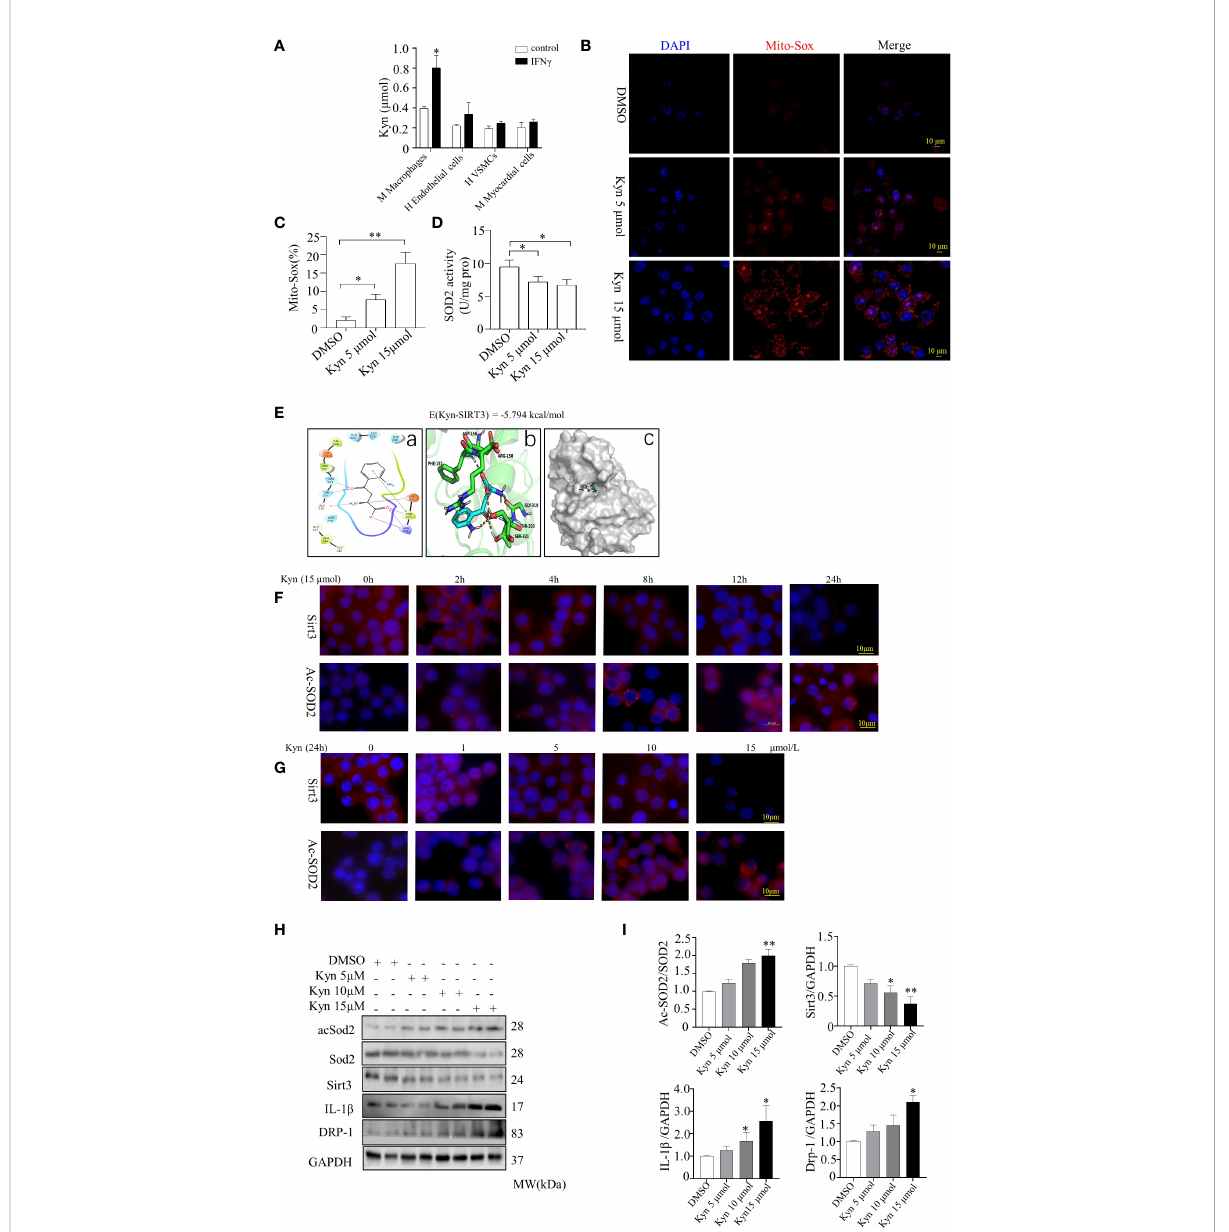
FIGURE 4 Kyn induced expression of in fl ammatory factors and increased the oxidative stress levels in macrophage cells and induced Sirt3. (A) Kyn expression were observed in the supernatant of macrophages, endothelial cells, VSMCs and myocardial cells stimulated with 20 ng/ml IFN g for 24 h. (B, C) Mitochondria-derived ROS stimulated by Kyn after 24 h was detected using MitoSox-probe (Red) and the nuclei were stained with Hoechst stain (Blue), (scale bar, 10 m m),*P<0.05 vs DMSO, **P<0.01 vs DMSO, n=3. (D) SOD activity was determined using a detection kit. Kyn increased the mitochondrial oxidative stress activity in macrophage cells, *P<0.05 vs DMSO, n=3. (E) Interaction of Kyn with Sirt3, the AutoDock predicted binding modes of Kyn with Sirt3, in which the carboxyl group at the Kyn terminus formed salt-bonding interactions with Arg-158 and hydrogen-bonding interactions with Phe-157 and Arg-158. The benzoyl group and the protonated amino group formed a cross-linked hydrogen bond network with Gly-319, Thr-320 and Ser-321. The binding energy predicted by autodock was displayed. (a) Two dimensional structure diagram, (b) Three dimensional structure diagram, (c) Overall structure diagram. (F, G) Immuno fl uorescence staining showed that Kyn induced Sirt3 and acSOD2 expression in a dose- and time-dependent manner. (F) Macrophage cells were treated with 15µM Kyn according to the different time. (G) Macrophage cells were incubated according to the various concentration of Kyn for 24 h (scale bar, 10 m m). (H, I) Representative blots and quanti fi cation of acSOD2, Sirt3, IL-1 b and DRP-1 protein expression of macrophage cells stimulated by 5,10 and 15 m mol Kyn differently. *P<0.05 vs DMSO, **P<0.01 vs DMSO,